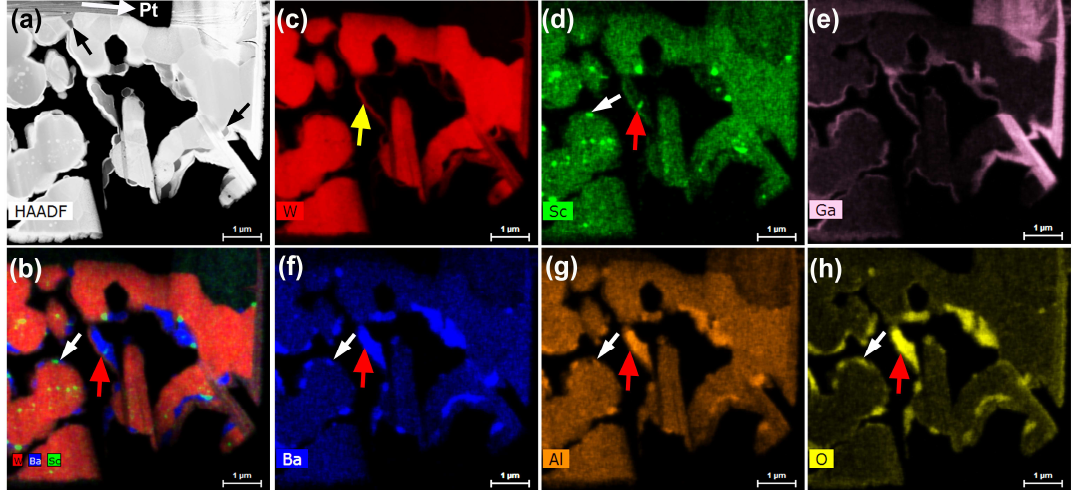
Figure 2. EDS elemental mapping of a cross-section TEM lamella from scandate cathode #1. ( a ) Low-magnification HAADF image of the electron-transparent sample region; ( b ) composite elemental map showing the distribution of W (red), Ba (blue) and Sc (green) in the TEM lamella; ( c – h ) elemental distribution maps for W, Sc, Ga, Ba, Al and